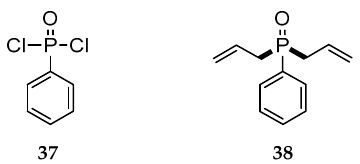
Figure 16. Structure of DOP-Cl 39 . The same reagents as described earlier were also used in another patent to prepare compound 39 (Figure 16) and was subsequently oxidized [78]. Next, esterification with phenols or polyhydroxybenzenes was performed to develop several flame retardants and one such example is